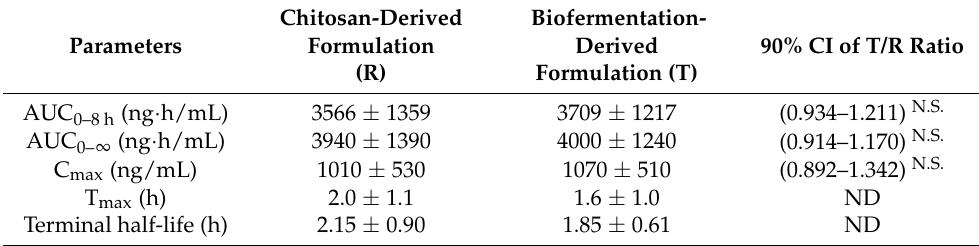
Figure 2. Mean plasma concertation-time profiles of glucosamine after an oral administration of 1500 mg of glucosamine sulfate 2KCl formulations to healthy volunteers. Shell (R), chitosan-derived formulation; and fermented (T), biofermentation-derived formulation.